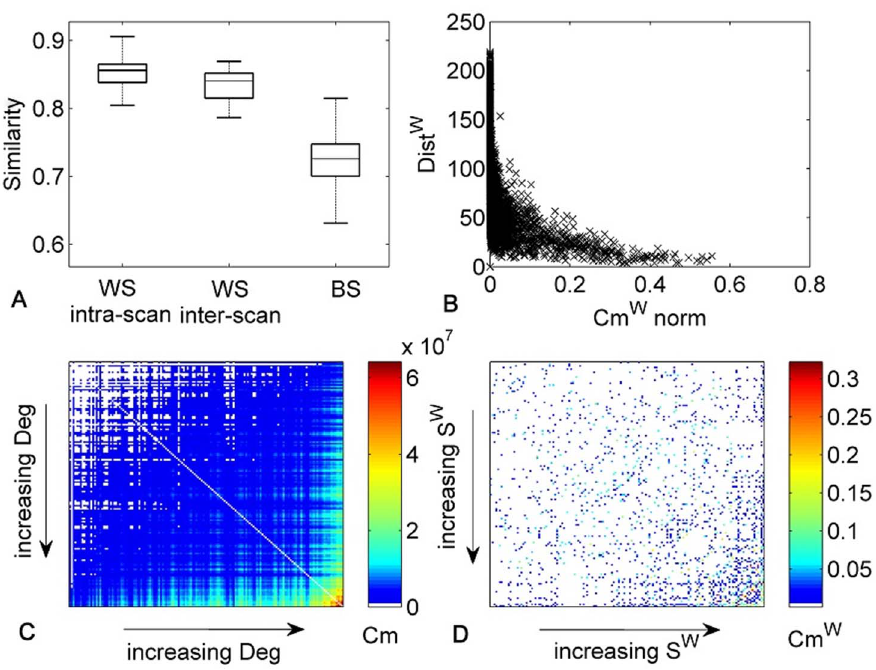
Fig. 1. Relationship between communicability, standard connectivity and distance measures. A) Boxplot of the correlations of C and Cm w respectively within subjects (WS) intra-scan, WS inter-scan, and between subjects (BS). B) Scatter plot of Cm w and Dist W matrices for the average network. C) Binary communicability assortativity matrix, i.e. Cm distribution among nodes with increasing Deg. D) Weighted communicability assortativity matrix, i.e. Cm w distribution between nodes with increasing S w .